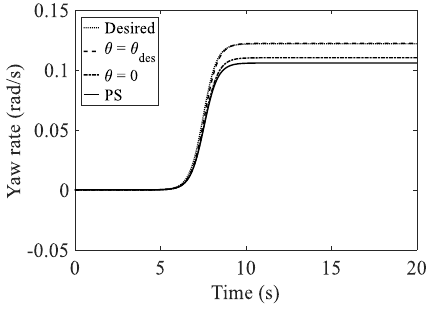
Figure 10. Yaw rate.